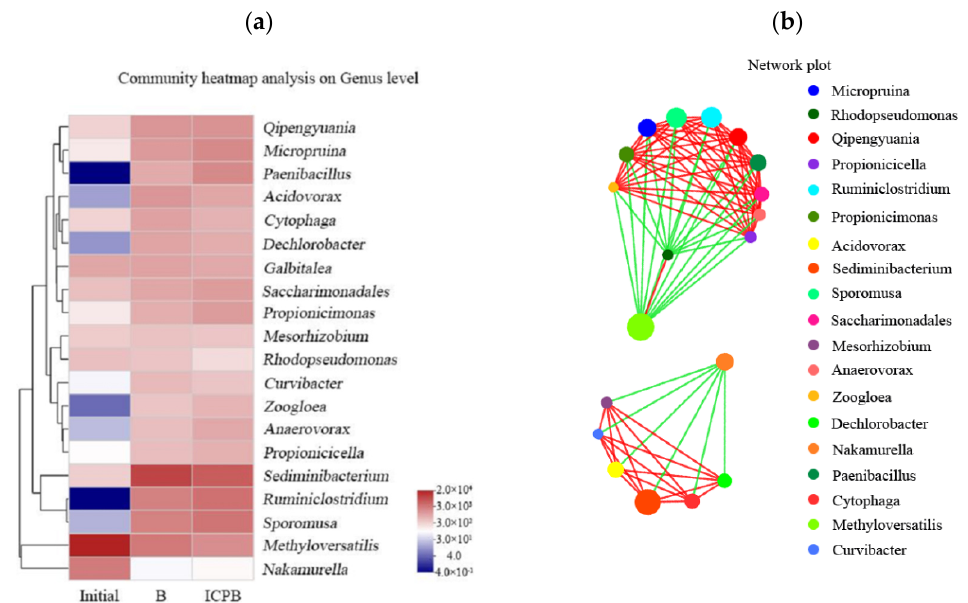
Figure 12. Correlation analysis of microflora. ( a ) Image of heatmap and relative abundances from low to high with colors varying from blue to red; ( b ) Network plot of the community, with each point referring to one kind of genus. The red and blue lines refer to the positive and negative correlations, respectively.